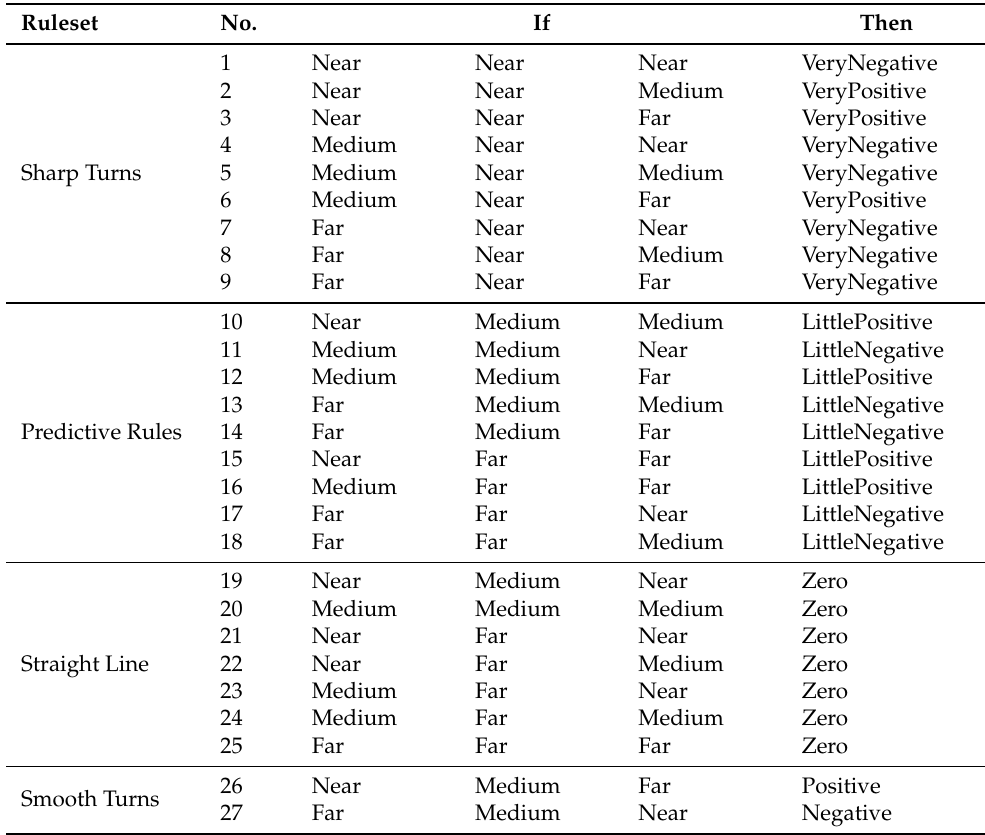
Table 1. Fuzzy Inference